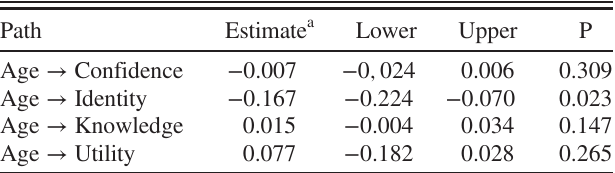
TABLE VII. Path differences between girls and boys for the model in Fig.